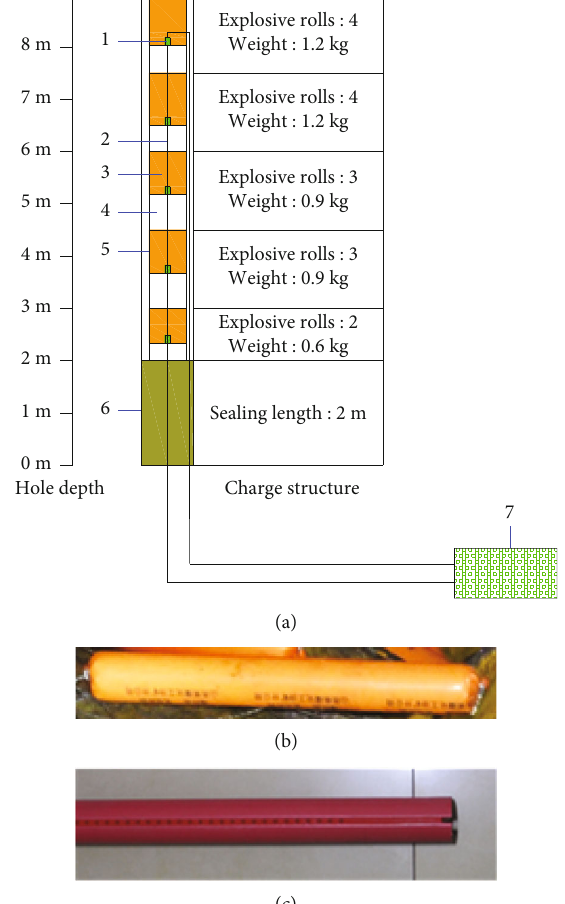
Figure 5: Charge structure of shaped charge blasting (SCB): (a) connection and charge structure in a single hole, (b) an explosive roll, and (c) directional slit tube (1: detonator; 2: connecting wire; 3: explosive; 4: air; 5: directional slit tube; 6: sealing mud; 7: detonating